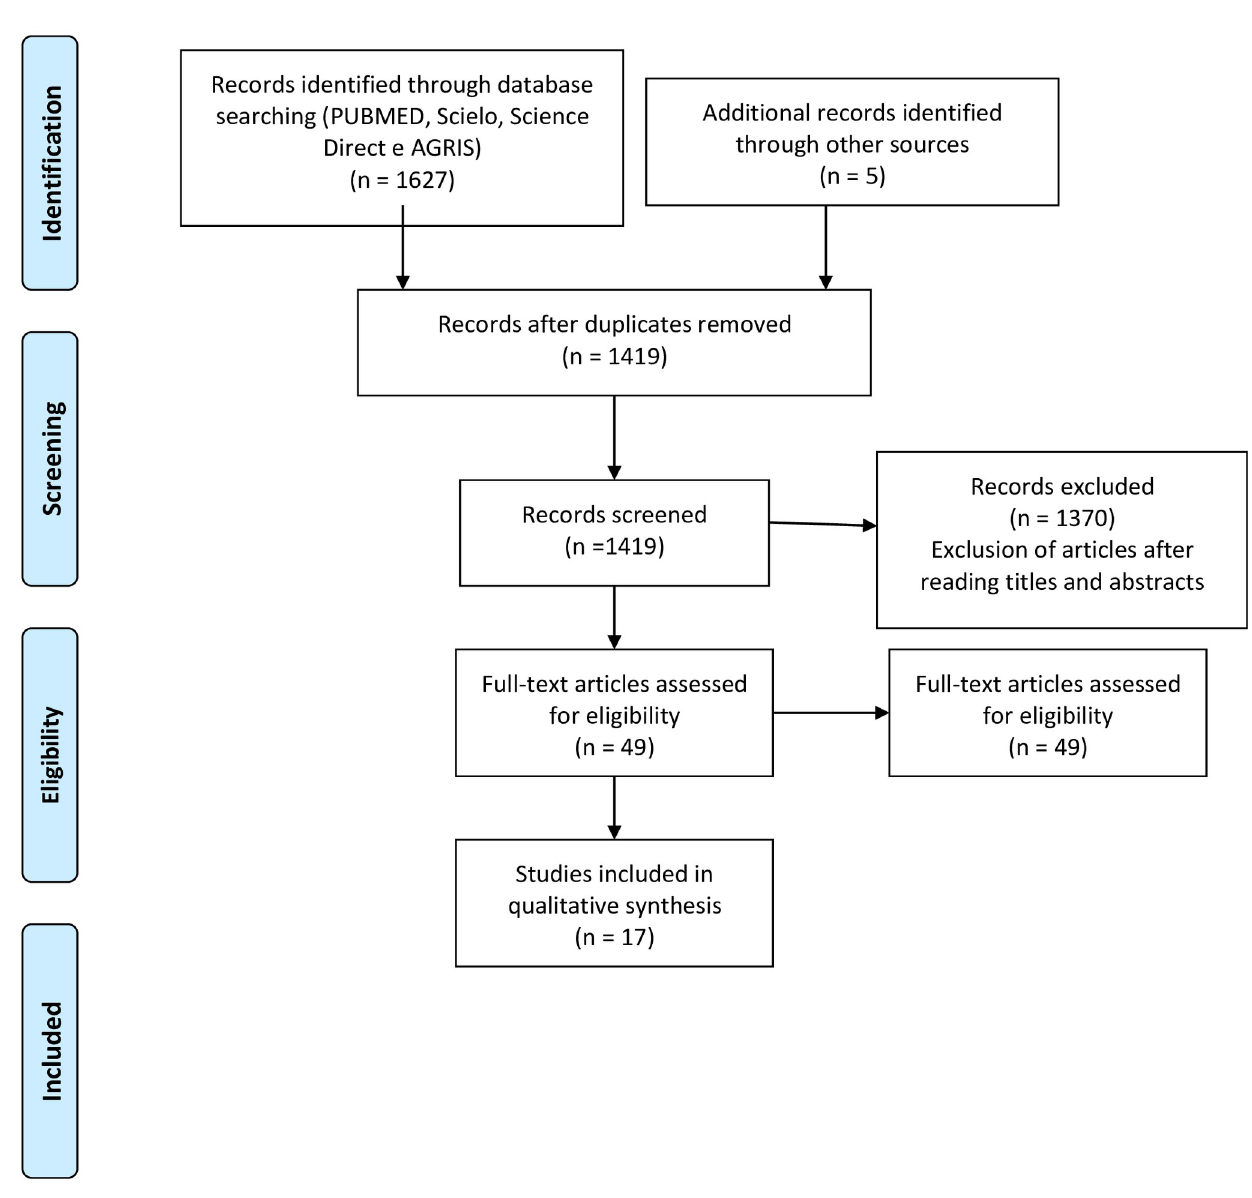
Fig 1. Prisma flow diagram. Preferred reporting items for systematic reviews and meta-analysis (PRISMA) flow diagram identifying the total number of articles initially surveyed, the number of articles included and excluded for this systematic review (Moher et al., 2009).